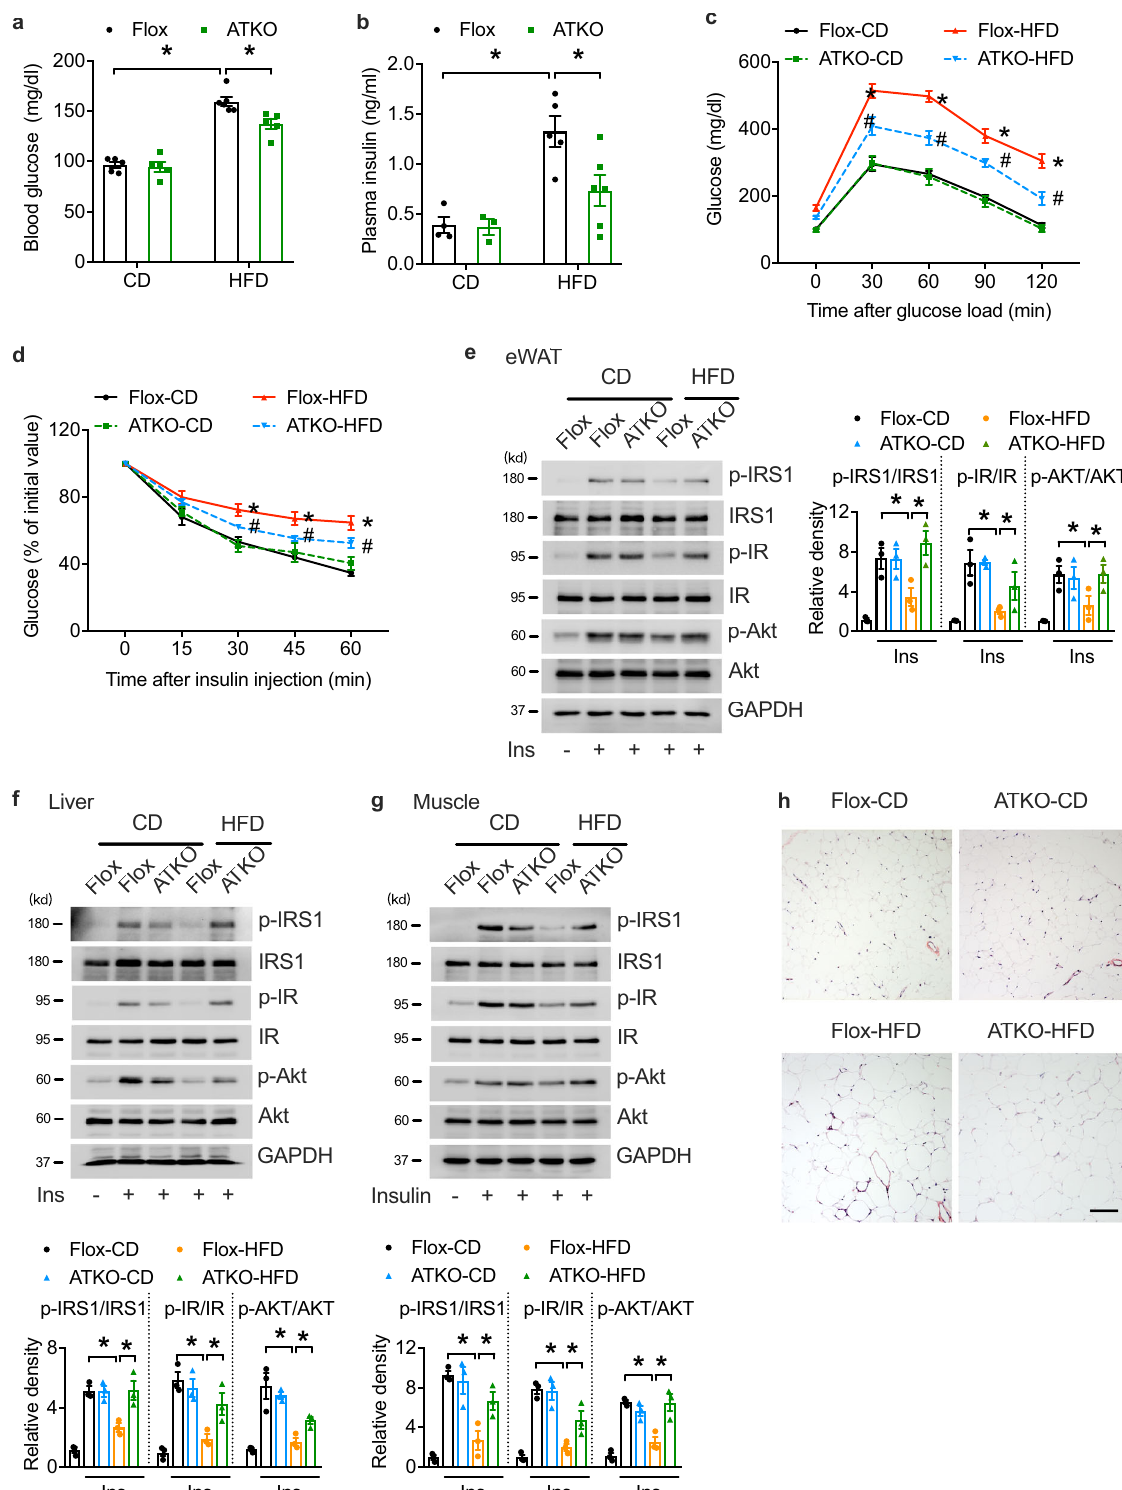
Fig. 2 | Adipocyte TRPM7 is required for glucose homeostasis and insulin sensitivity in vivo. a , b Serum glucose ( a , n=5 mice for Flox-CD, ATKO-CD, ATKO-HFD, n =6 mice for Flox-HFD) and insulin ( b , n =4 mice for Flox-CD, n =3 mice for ATKO-CD, n =5 mice for Flox-HFD, n =6 mice for ATKO-HFD) levels in overnight-fastedFloxandATKOmicefedwithCDorHFD. c , d Glucosetolerance test ( c , n =6 mice for Flox-CD, ATKO-CD, Flox-HFD, n =5 mice for ATKO-HFD) and insulin tolerance test ( d , n =5 mice) in Flox and ATKO mice fed with CD or HFD, *comparison of Flox-HFD vs. Flox-CD, # comparison of ATKO-HFD vs.